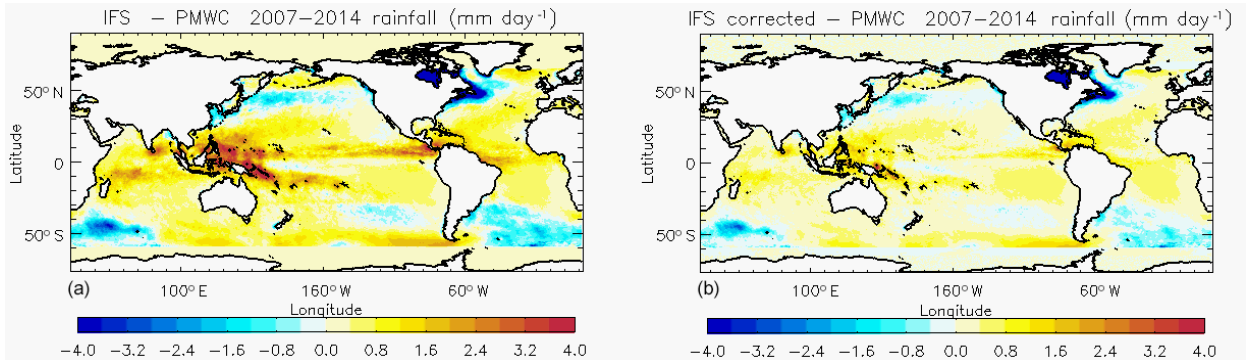
Figure 6. Mean 2007–2014 IFS ECMWF atmospheric precipitation bias (units in mmday − 1 ) with respect to PMWC product without (a) and with (b)